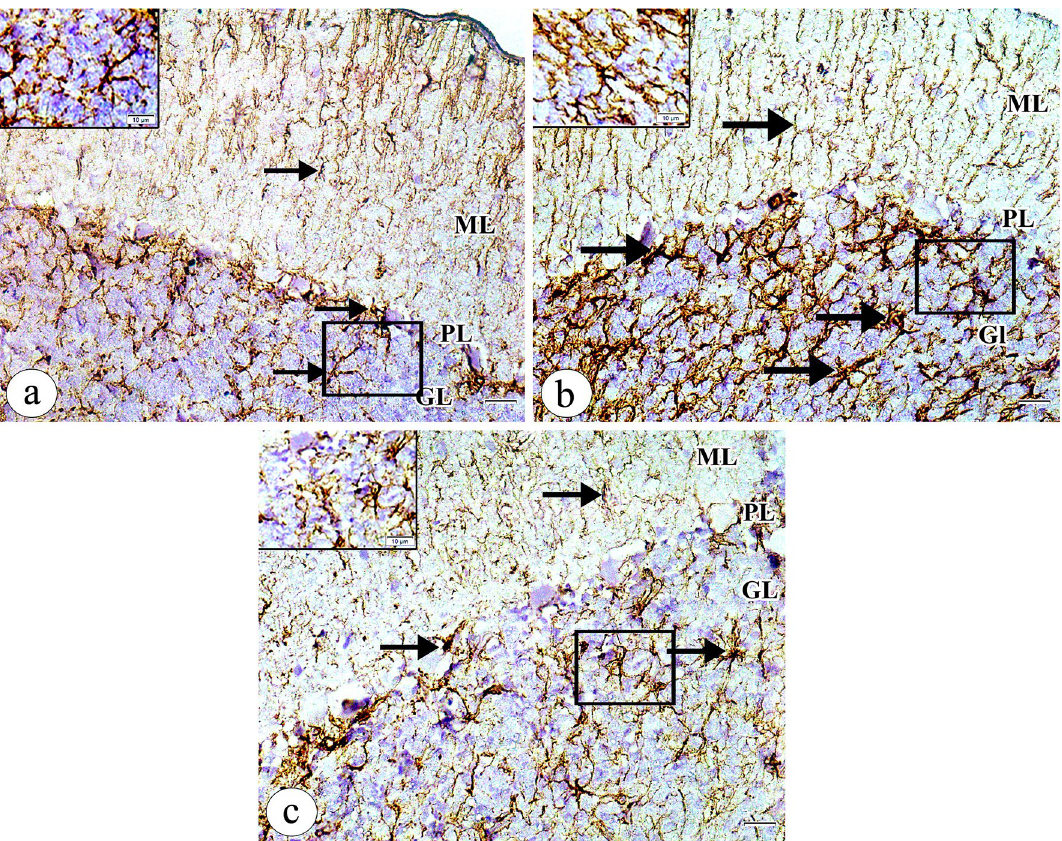
Figure 3. A photomicrograph of the sections of the cerebellar cortex in ( a ) the control group showing scanty mild positive GFAP immunoreactivity in the processes of the glial cells (arrow) in the molecular layer (ML), Purkinje cell layer (PL) and granular cell layer (GL). ( b ) the tartrazine treated group showing abundant strong positive GFAP immunoreactivity in the processes of the glial cells (arrow) in the molecular layer (ML), Purkinje cell layer (PL), and granular cell layer (GL). The glial cells reveal several thick branched processes when compared with controls. ( c ) the tartrazine + riboflavin treated group showing moderate positive GFAP immunoreactivity in the processes of the glial cells (arrow) in the molecular layer (ML), Purkinje cell layer (PL), and granular cell layer (GL). (GFAP counterstained with Mayer’s haematoxylin, ×400, scale bar = 20 μm, inset: ×1000, scale bar = 10 μm